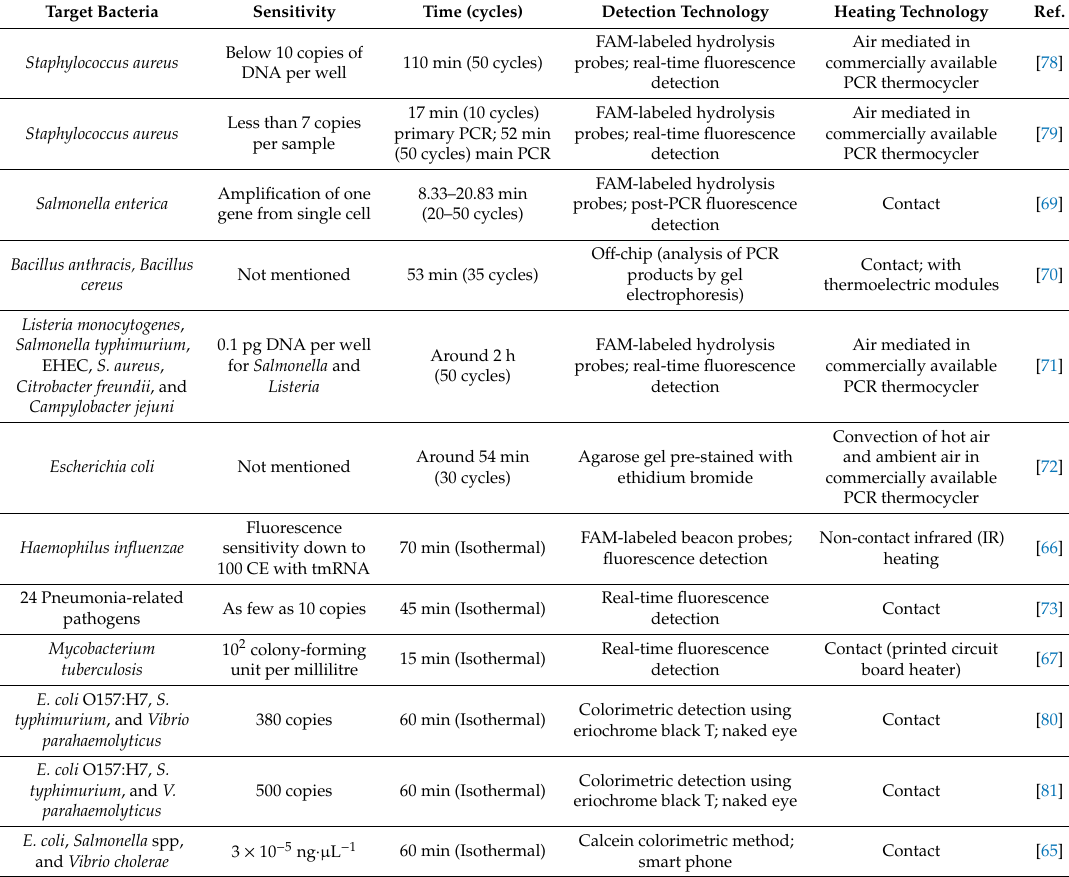
Table 2. Summary of key studies using centrifugal microfluidics to identify